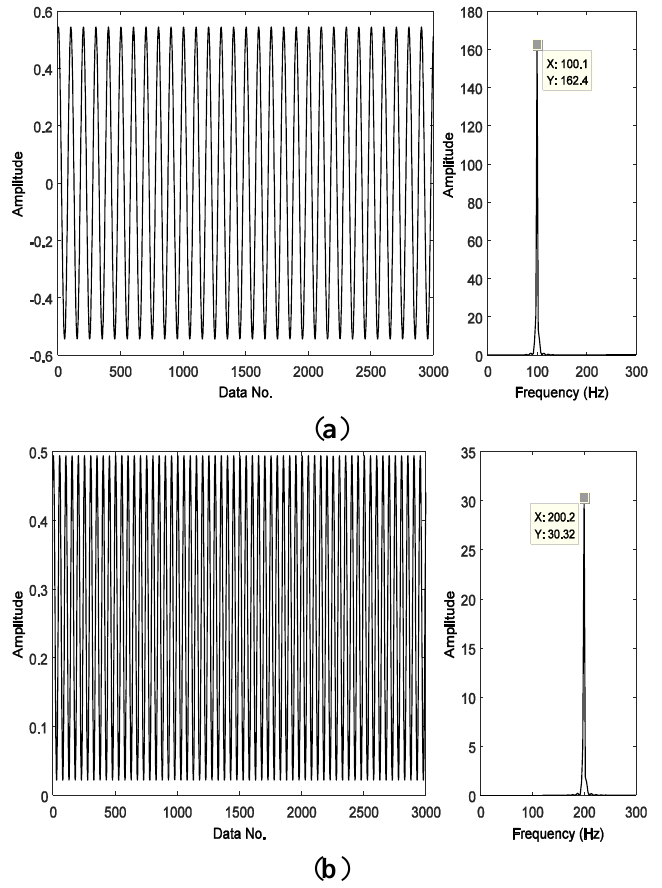
Figure 5. The first two detected harmonic components and their frequencies: ( a ) the first harmonic and its frequency; and ( b ) the second harmonic and its